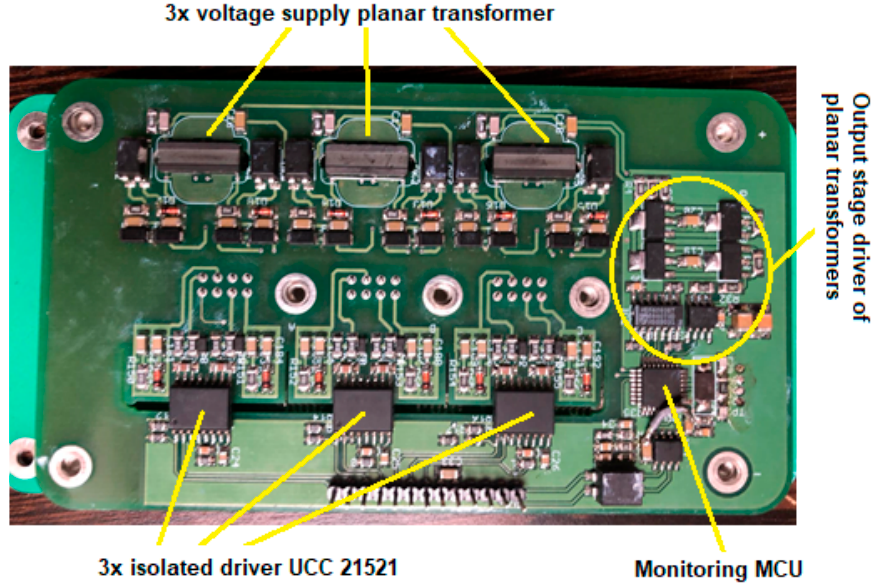
Figure 6. Physical prototype of driving board of proposed PFC converter.